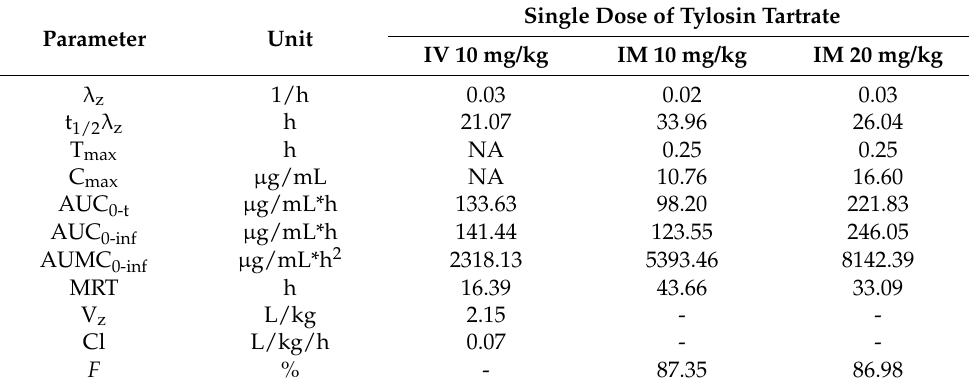
Figure 2. A semilogarithmic plot of the tylosin concentration–time profile in serum following a single intramuscular administration at 10 and 20 mg/kg. Data are expressed as mean ± SD from 10 olive flounders at each time point. The minimum inhibitory concentration (MIC) value corresponds to Streptococcus parauberis MIC 90 (1 µg/mL) and S. iniae MIC 90 (0.5 µg/mL). Table 2. Pharmacokinetic parameters of tylosin tartrate following a single intramuscular and intra- venous administration to olive flounder.